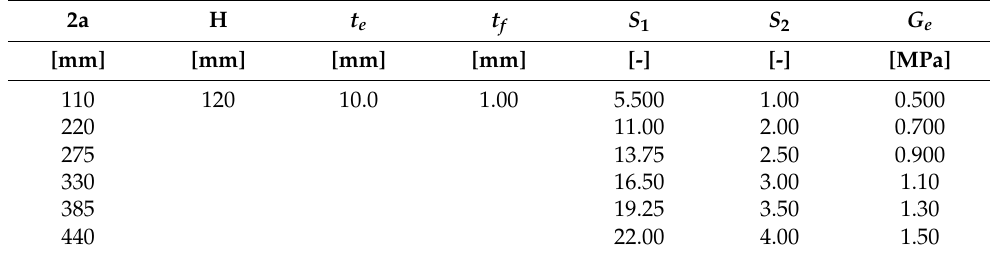
Table 4. Overview of the geometric and mechanical parameters used for the parametric